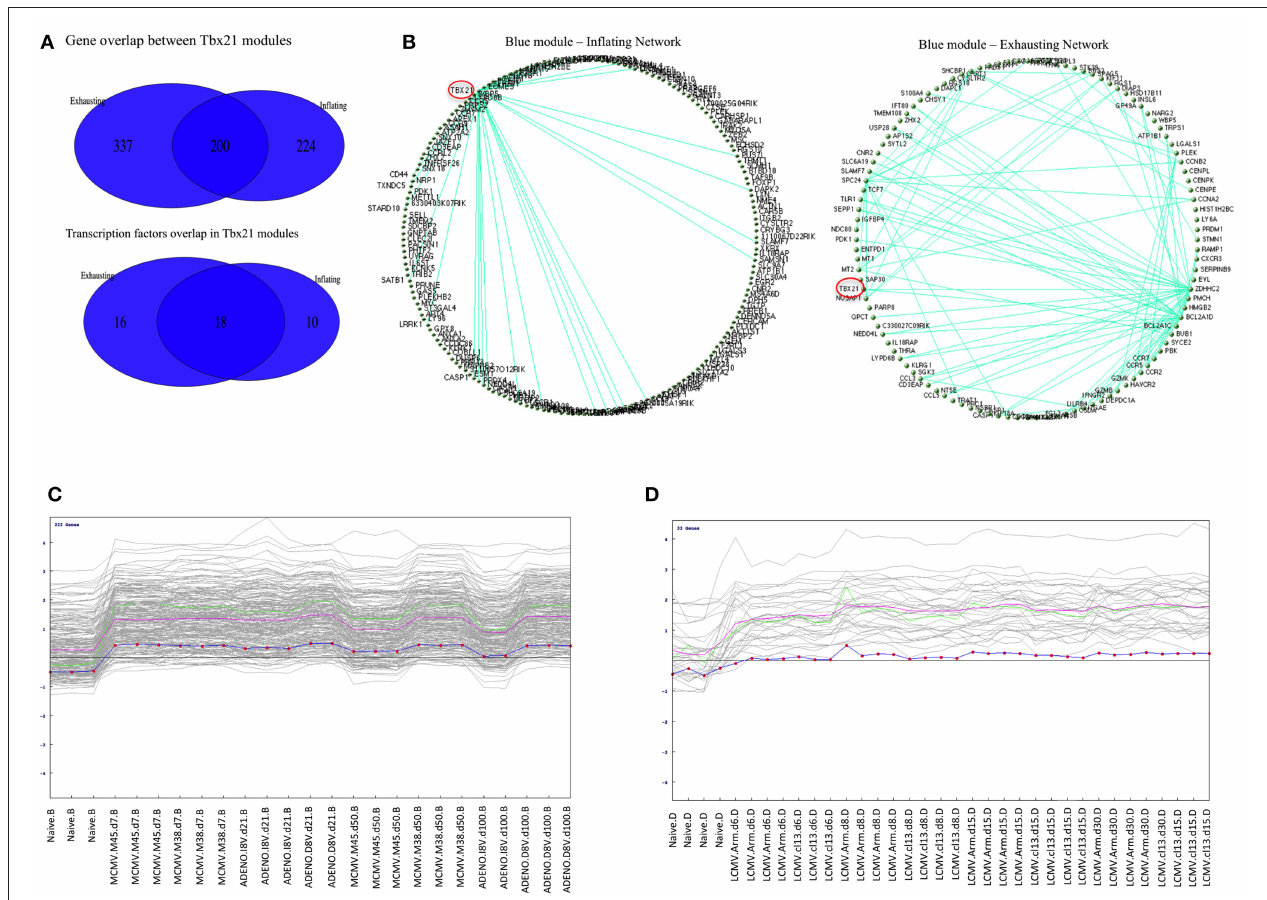
FIGURE 5 | (A) Overlap between Inflation and Exhausted gene modules. Venn diagrams showing gene content overlap between modules containing Tbx21 detected when WGCNA was performed independently on Inflating and Exhausted data sets. (B) Graphical representation of Blue modules networks. Circular topology imposed to blue modules (containing Tbx21) detected in Inflating and Exhausting data sets visualize nodes (genes) with highest connectivity. Only edges with a weight > 0.41 (for Inflating) and > 54 were plotted. Tbx21 (highlighted in red) is the main hub in Inflating blue module, being the gene with the highest number of connection with other genes. In the Exhausted blue module, although highly expressed, Tbx21 loses the property of being the only hub. (C) Pavlidis Template test in Inflating data Set. Tbx21 used as template for detecting genes with matching expression trajectory across time points. In the Inflating data set 222 genes match the Tbx21 expression pattern ( R > 0.8); The green line is the template (Tbx21), the violet line represents average expression, and the dotted line is the centralized ( z -score) template expression. (D) Pavlidis Template test in Exhausted data Set. Tbx21 used as template for a method designed to retrieve other genes with a similar